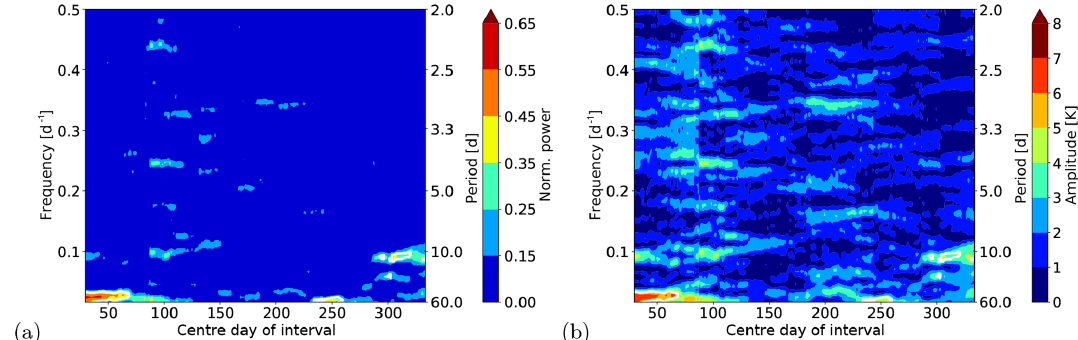
Figure 8. Results for the normalised power and amplitude for the analysis of the temperature residual of the GRIPS observations in 1989. The results are displayed at the centre day of the corresponding time window. The length of the time window was 60d. The white contours mark the significant